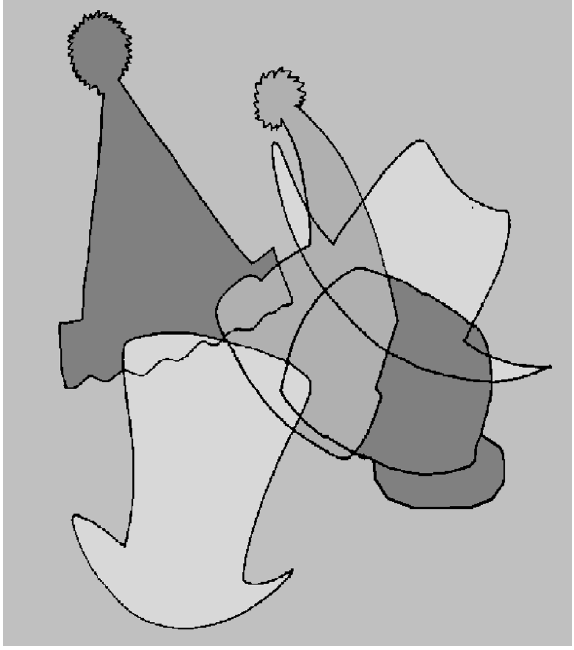
Figura 2 . Exemplo de Item que Compõe o Teste